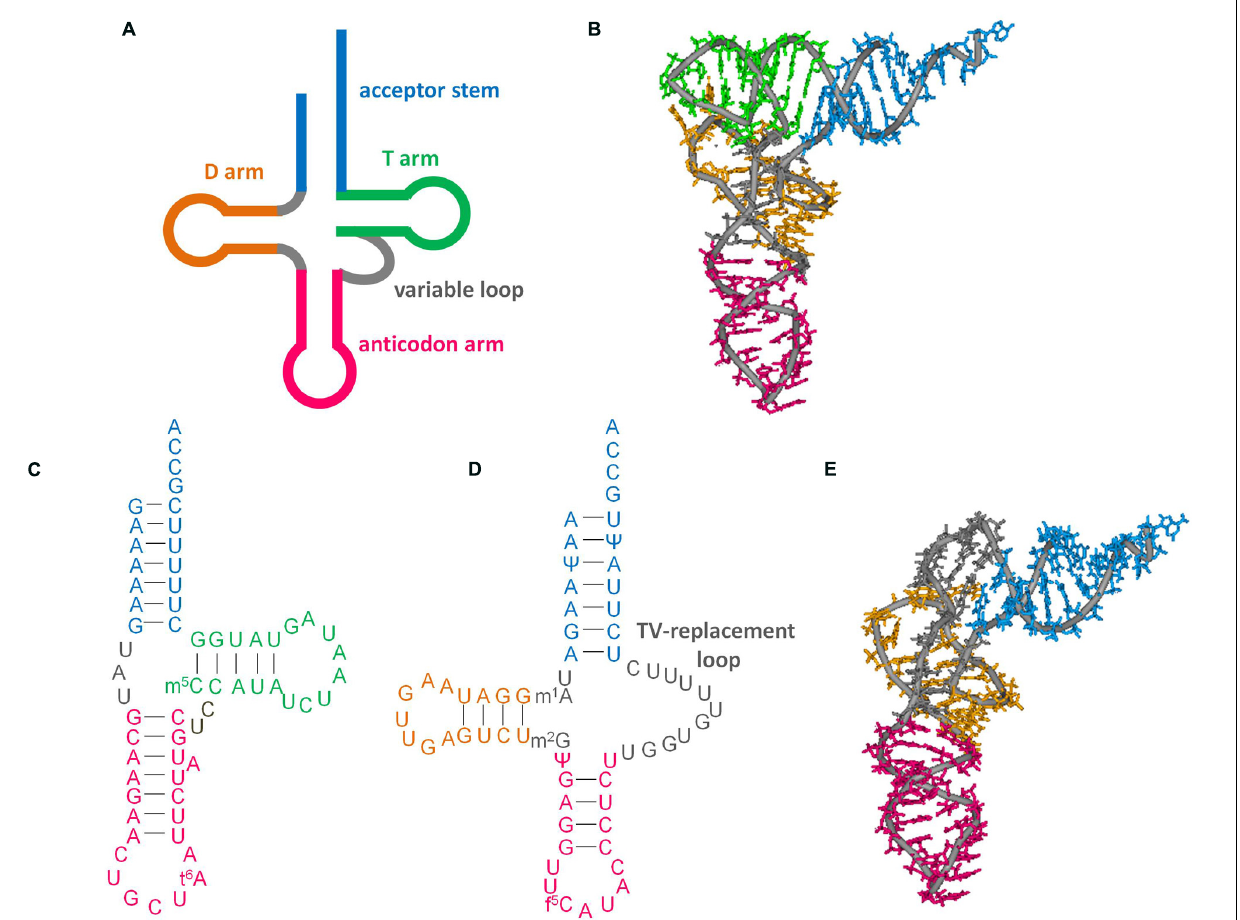
FIGURE 1 | Secondary and tertiary structures of tRNAs. (A) Cloverleaf tRNA. (B) L-shape tertiary structure of cloverleaf tRNA ( Saccharomyces cerevisiae tRNA Phe , PDB code 6TNA). (C) D-arm-lacking tRNA (bovine mt tRNA Ser (GCU), accession number: X15132. Modification data from tRNAdb (Jühling etal., 2009), tRNAdb ID: tdbR0000402). (D) T-arm-lacking tRNA ( Ascaris suum mt tRNA Met , accession number: D28746; Watanabe etal., 1994; Sakurai etal., 2005b). (E) L-shape model